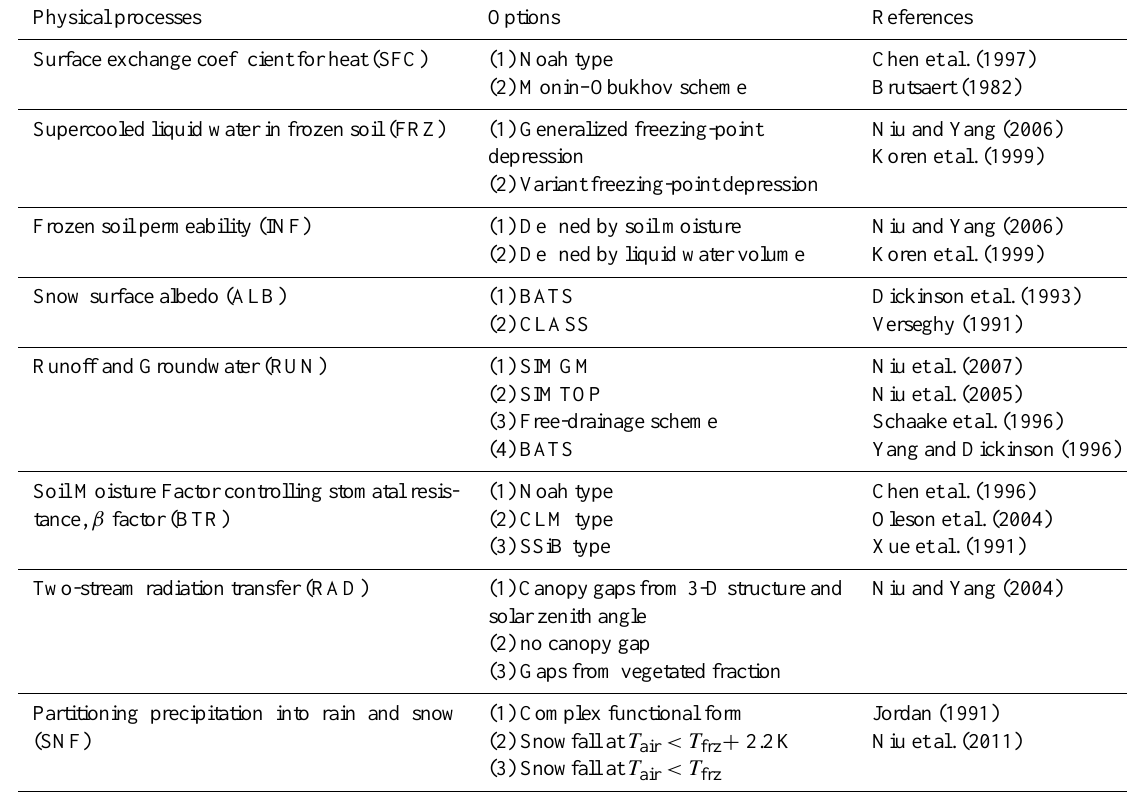
Table 1. Summary of scheme options available in